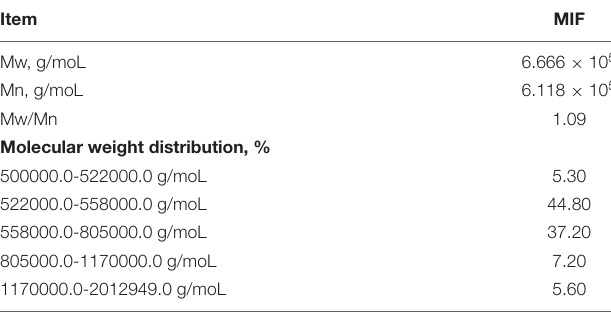
TABLE 1 | Molecular weight and its distribution of Morchella importuna